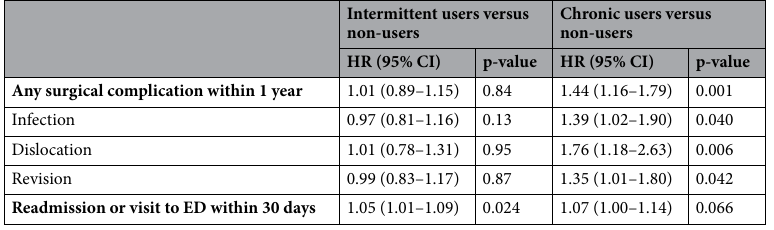
Table 3. Risk for complications after